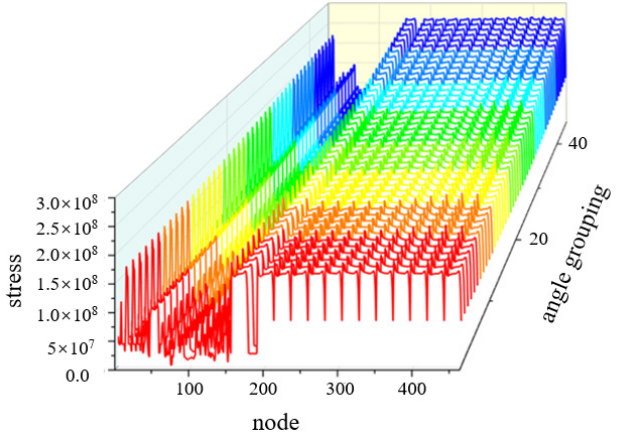
Figure 15. Comparison of stress at different angles after program optimization.